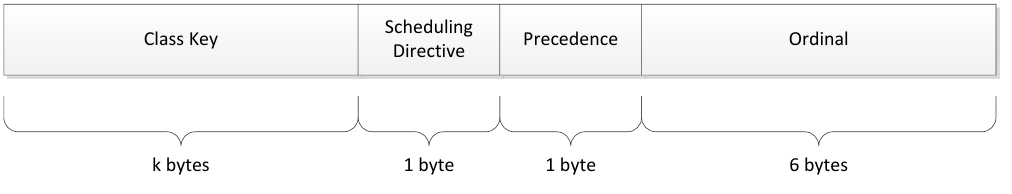
Figure 5. The structure of the key corresponding to an entry of a URL scheduled for crawling in the default frontier of Heritrix.